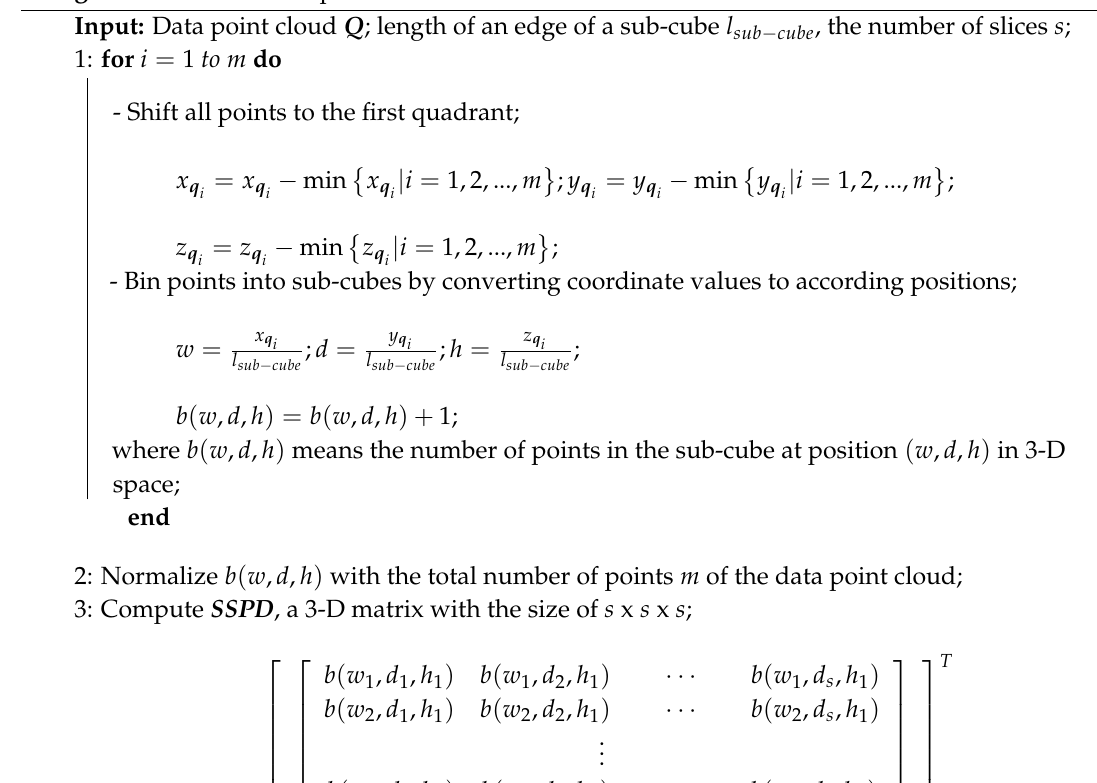
Algorithm 2 Offline computations of